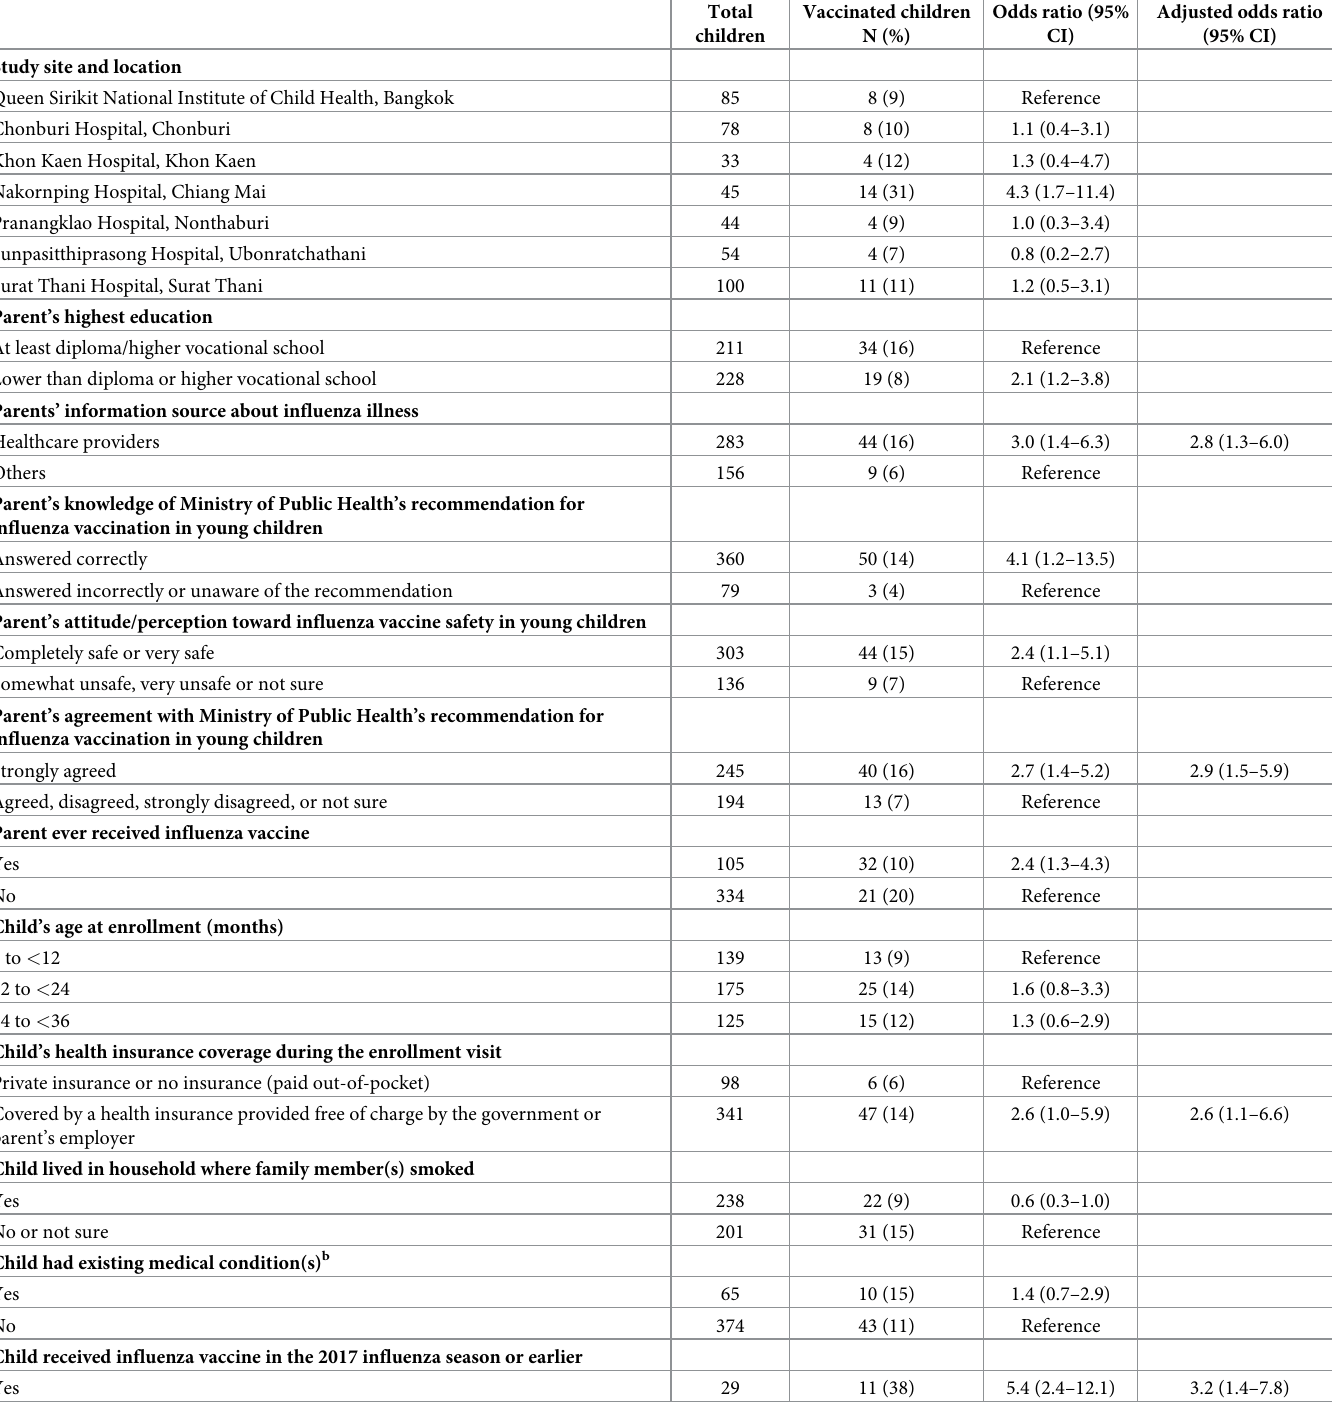
Table 3. Factors associated with children having received influenza vaccination in the 2018 influenza season a